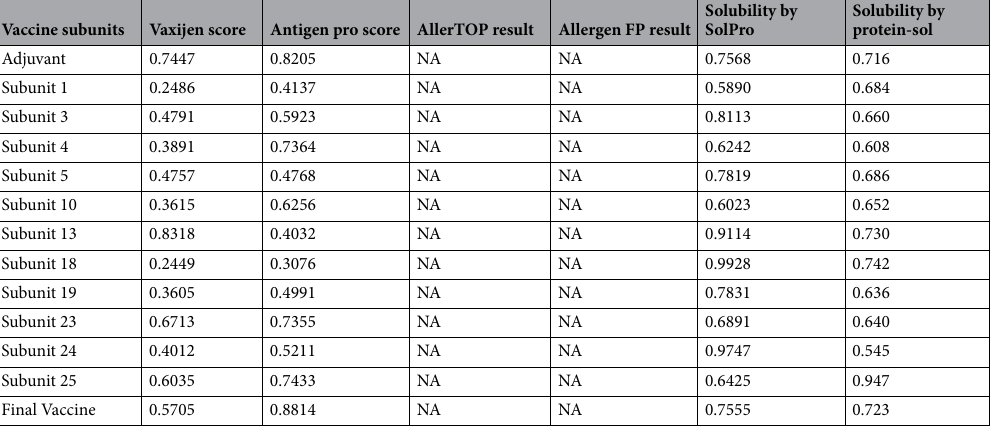
Vaccine subunits Vaxijen score Antigen pro score AllerTOP result Allergen FP result